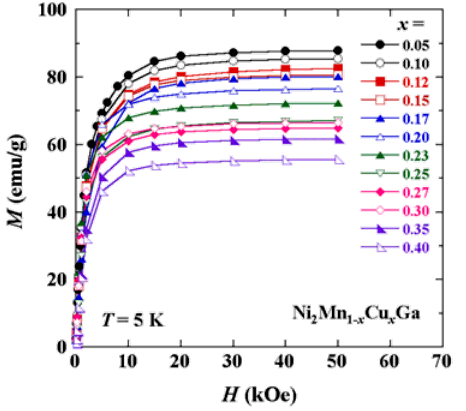
Figure 3. Magnetization curves at 5 K for Ni various concentration x .